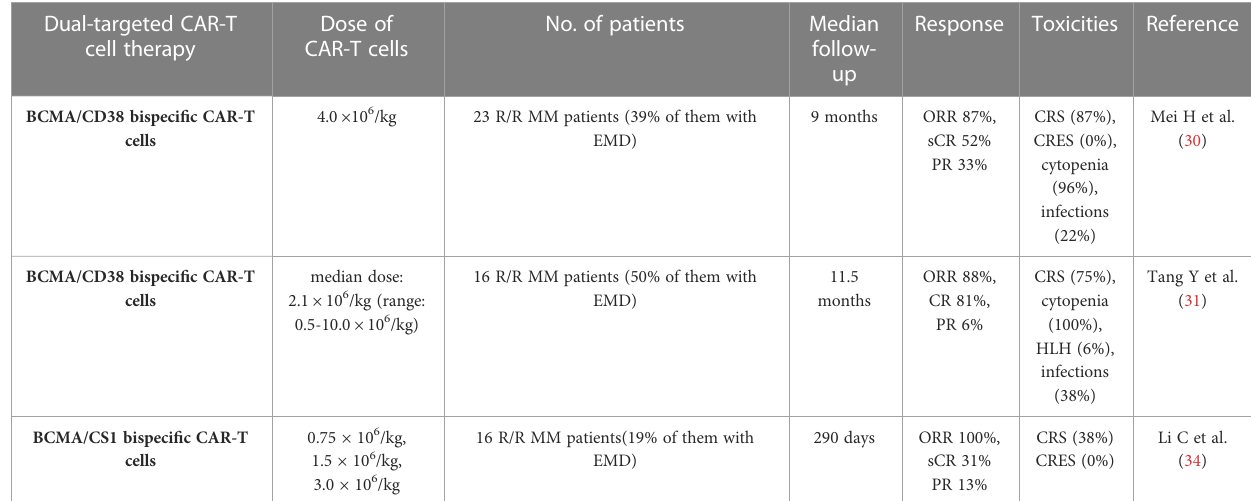
TABLE 1 Clinical trials of dual-targeted CAR-T cell therapy in